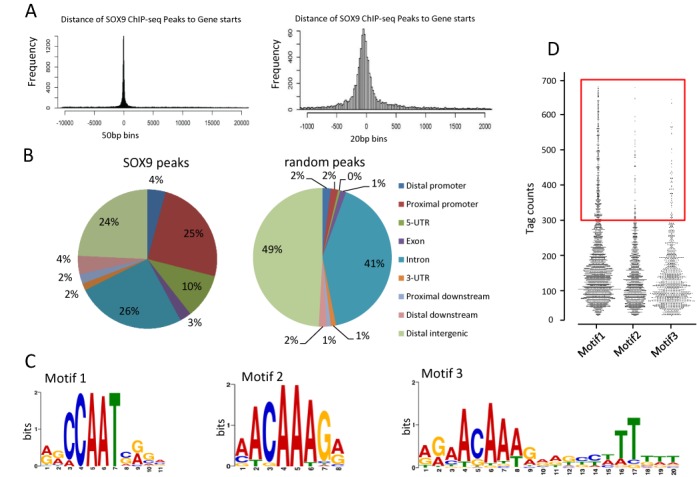
ChIP-seq analysis of SOX9 binding sites in HT29 cells. (A) Distribution of SOX9 binding sites relative to nearest TSSs. Histograms were generated from the putative SOX9 binding regions. The left plot (50-bp bins) shows that SOX9- binding sites are enriched symmetrically around TSSs. The right plot (20-bp bins) shows the preferential location between 0 and −100 bp upstream of TSSs. The x-axes represent relative distance (bp) from the TSS. The y-axes represent the frequency of peaks in the whole genome. (B) Distribution of SOX9 binding site location relative to RefSeq genes. Locations of binding sites are divided into distal promoter (−1 to −3 kb upstream of TSS), proximal promoter (−1 to 0 kb), 5′ UTR, exon, intron, 3′ UTR, proximal downstream (0–1 kb downstream of TSS), distal downstream (1 to 3 kb downstream of TSS) and distal intergenic (>3 kb from genes). (C) Motif analysis from SOX9 ChIP-seq. With identification of statistically over-represented sequences present in ChIP-seq binding loci. A de novo putative binding motif was denoted Motif 1, in addition to previously identified consensus motifs, Motif 2 and 3. (D) Comparison of tag counts of Motif 1, 2 and 3 genes are demonstrated by the frequency distribution. The red box indicates genes with more than 300 tags.